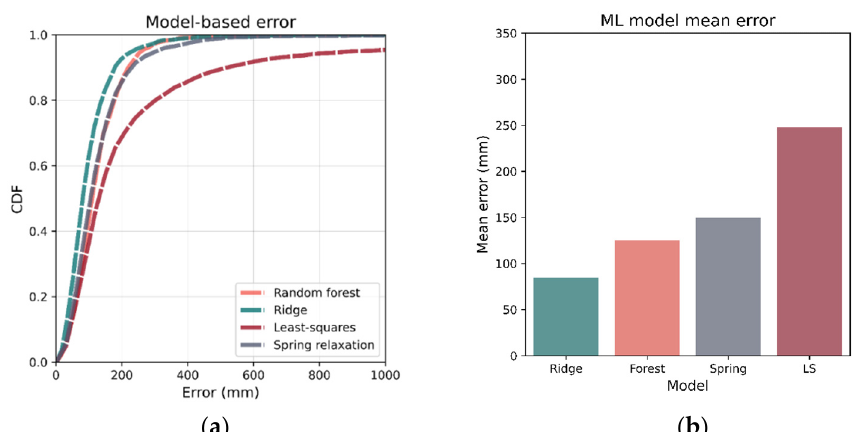
Figure 21. CDF and mean of localization errors for channel model-based positioning are benchmarked in ( a , b ) respectively. Spring relaxation was the better performing of the model-based techniques, although its performance was slightly lower than that of RF—the worst-performing ML model. The least-squares method was considerably worse than any of the other methods. The models were trained/calibrated on the entire 80% training set and tested on the 20% test set.